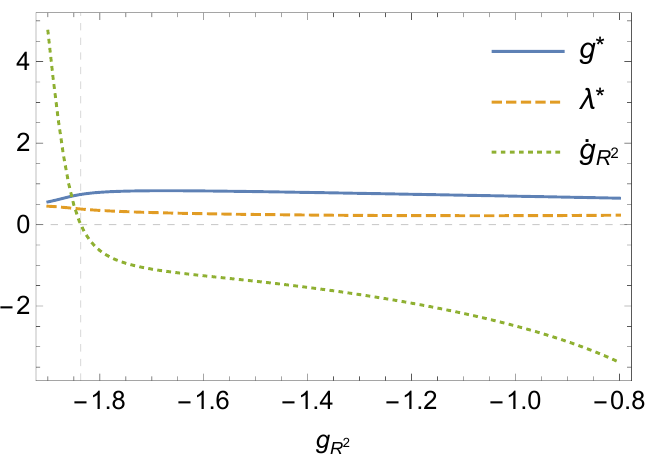
Figure 3: The partial fixed points for g (solid blue line) and λ (dashed orange line) as well as the beta function ˙ g (dotted green line) evaluated on the partial fixed R 2 point, as a function of negative g . The dashed grey horizontal line indicates zero, R 2 whereas the dashed grey vertical line indicates the combined fixed